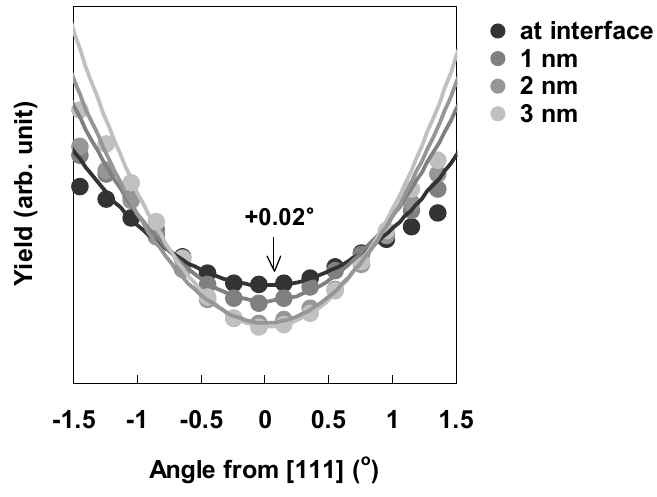
Figure 17. Scattering yield from Si at various depths from the interface as a function of the incident angle relative to the [111] direction for the specimen annealed in an oxygen ambient.